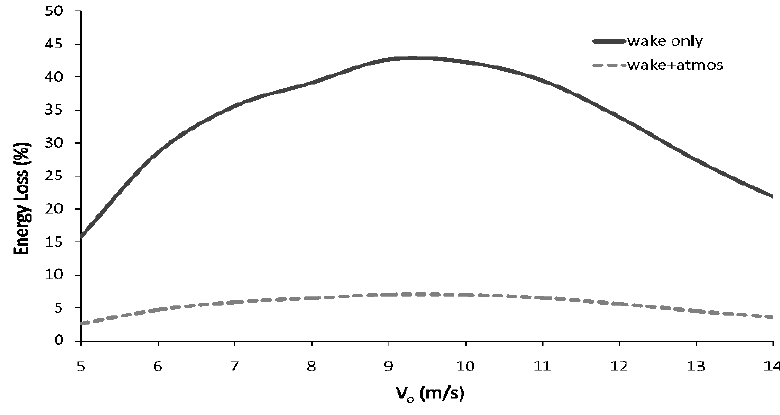
Figure 10. Energy loss (%) calculated using Equation (11) (solid line) and this same loss after factoring in the fraction of atmosphere actually affected by the wake (dashed line). In the case of a wind farm with 3D × 10D spacing, this fraction is 13πD/36 h (see Equation